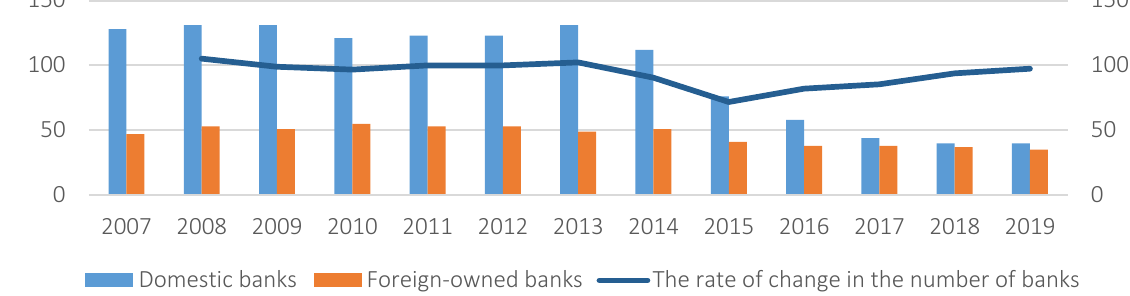
Figure 10. Dynamics of the number of banks in